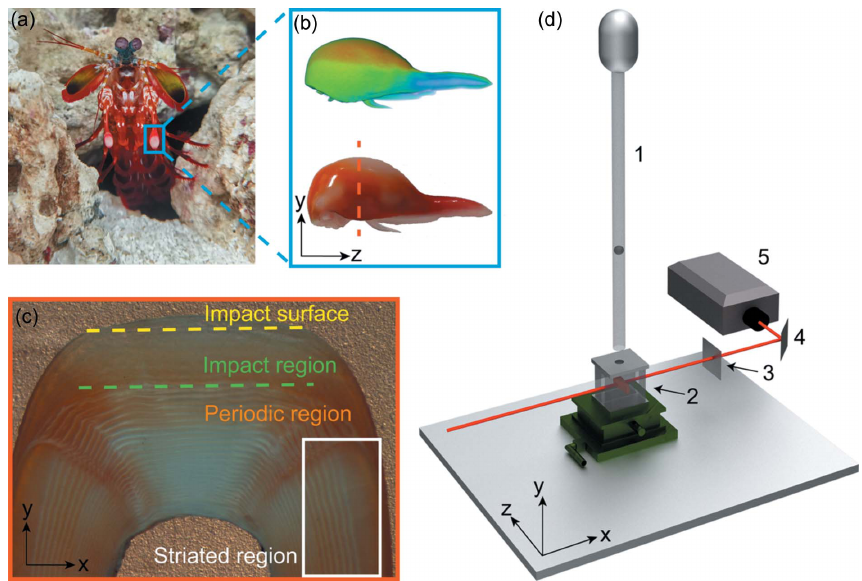
Figure 1 Samples and experimental setup. ( a ) Photograph of Odontodactylus scyllarus with dactyl club indicated (blue square). ( b ) Top: 3D rendering of dactyl club based on laboratory CTresult. Bottom: photograph of the dactyl club separated from raptorial appendage. ( c ) Optical microscopy image of a cross- section of dactyl club from ( b ) sectioned along the red dashed line. The impact surface, impact region, periodic region and striated region are depicted in ( c ). ( d ) Schematic of the experimental setup for the in situ impact test equipped with a high-speed X-ray imaging system. 1: gas gun; 2: sample holder; 3: scintillator; 4: mirror, 5: high-speed